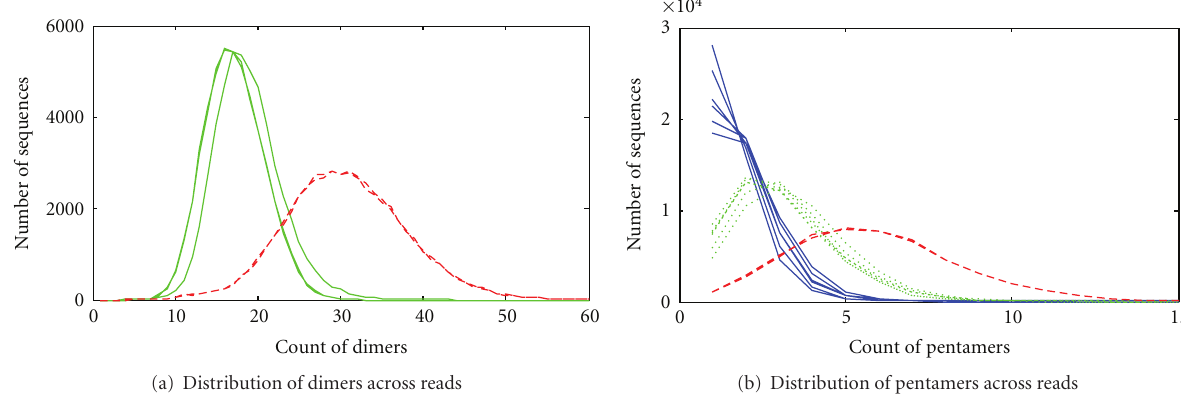
Figure 1: Distribution of dimers and pentamers across 50,000 reads sampled from the genome of Haemophilus influenzae (only a few distributions are shown). (a) Distribution of dimers tends to Gaussian, two groups can be observed. (b) Distribution of pentamers tends to Poisson, three groups are